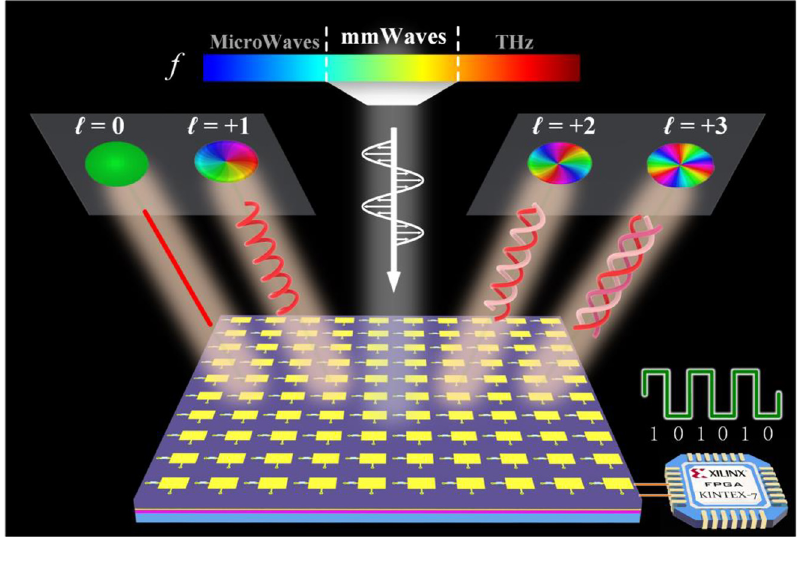
Figure 1: Schematic diagram of the programmable mmWave metasurface for dynamic OAM beam generation.